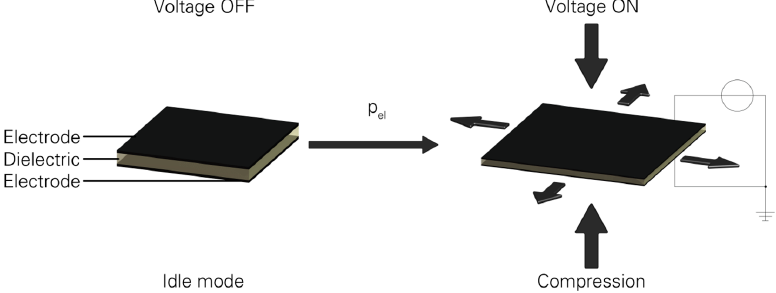
Figure 1. Scheme of the operating principle of a dielectric elastomer actuator (DEA) [3,4,15].